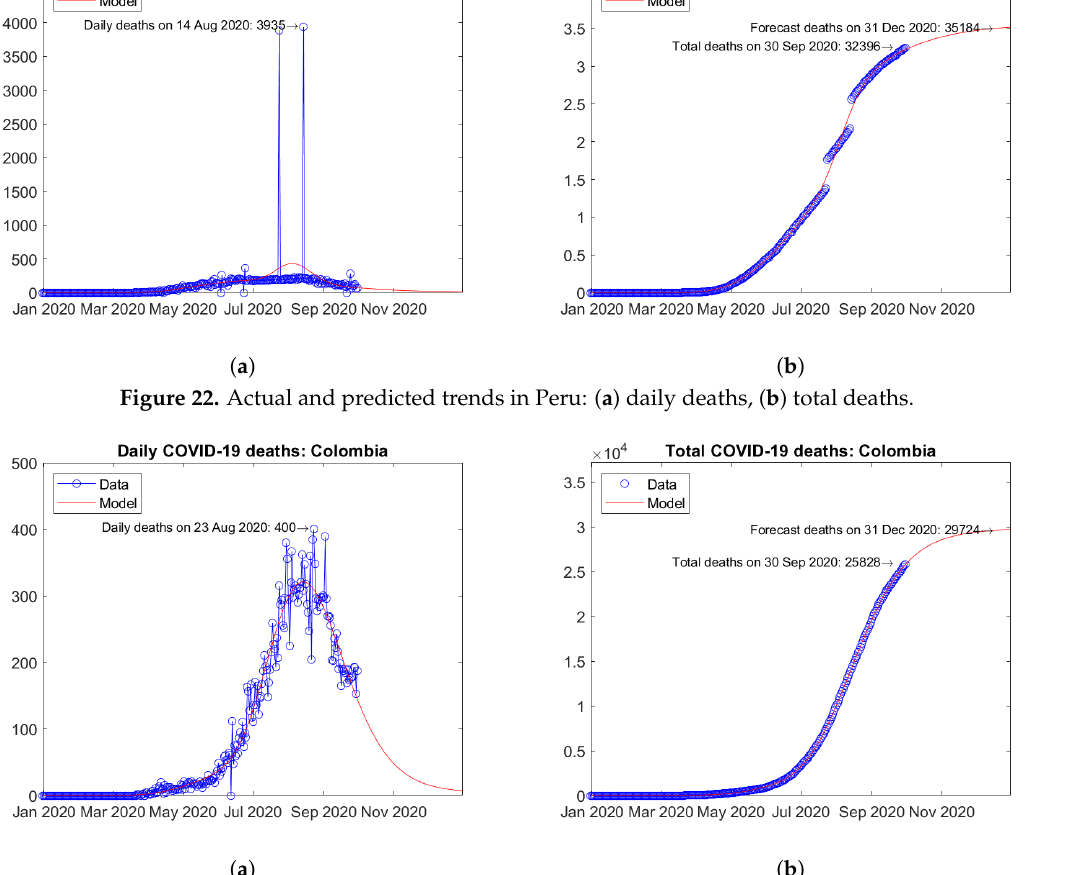
Figure 23. Actual and predicted trends in Colombia: ( a ) daily deaths, ( b ) total